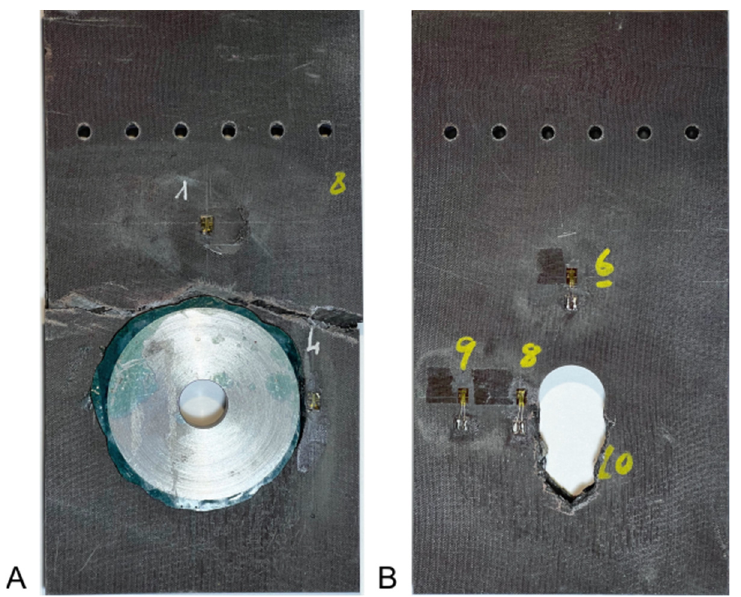
Figure 5. Experimental failure modes: ( A ) for the advanced joint, ( B ) for the not reinforced joint. A similar failure mode has been determined for the solid configuration. Table 4. Experimental static failure load for different CFRP samples in initial and advanced config- uration (A-i = solid laminate; B-i = sandwich laminate).